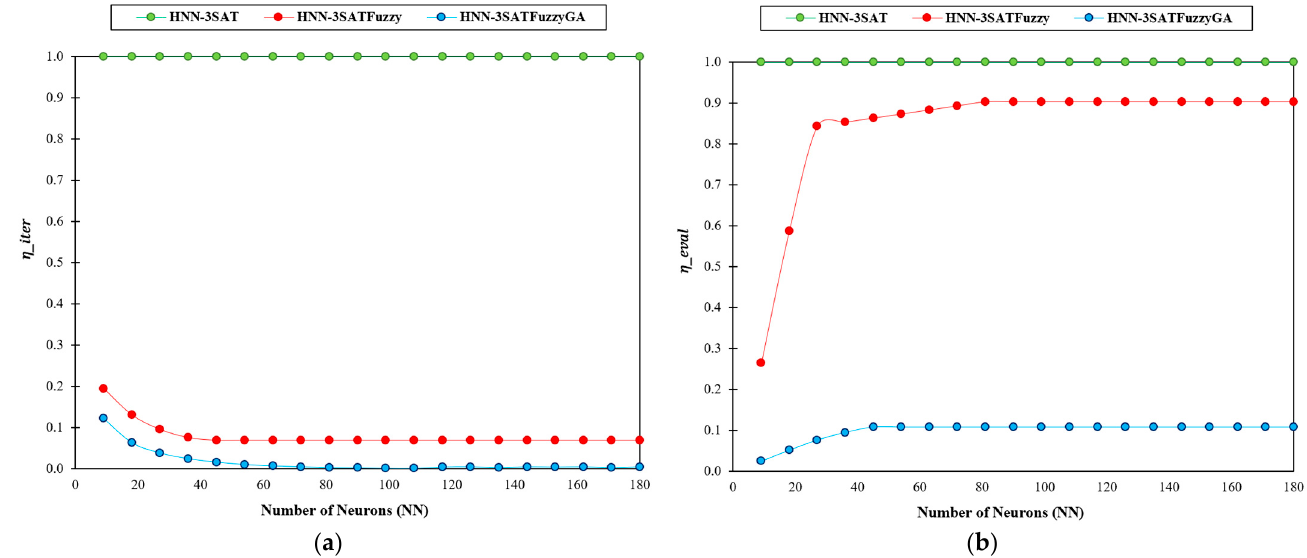
Figure 4. The efficiency performance metrics in the training phase: ( a ) iteration efficiency; ( b ) evaluation efficiency.